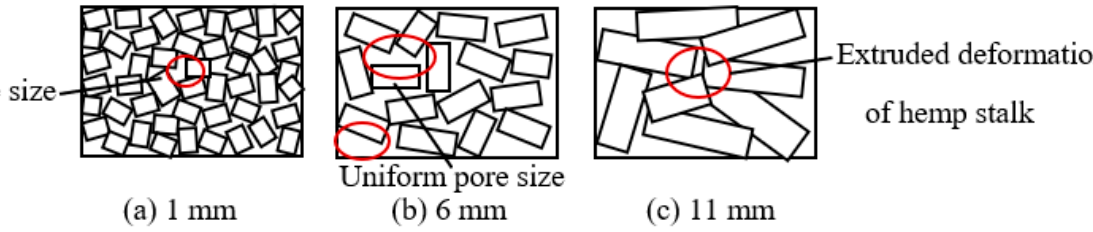
Figure 8. Schematic diagram of the principle behind the sound absorption performance of different stalk lengths.